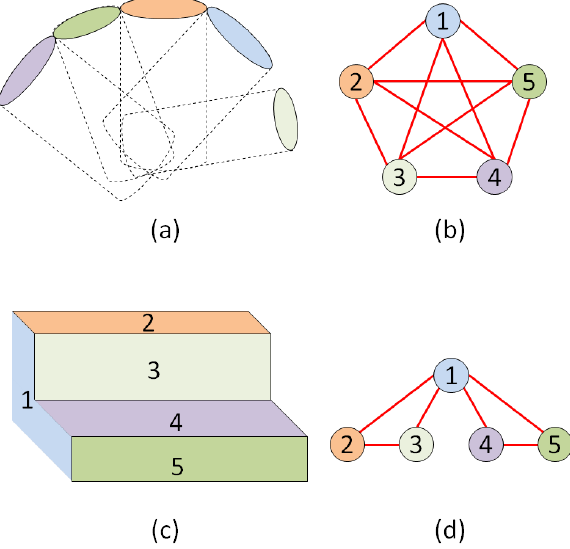
Figure 4: SVPs voting for freeform objects: SVPs can be assem- bled from arbitrary angles (a) and form concave shapes (c) when they are either fully (b) or partially (d)